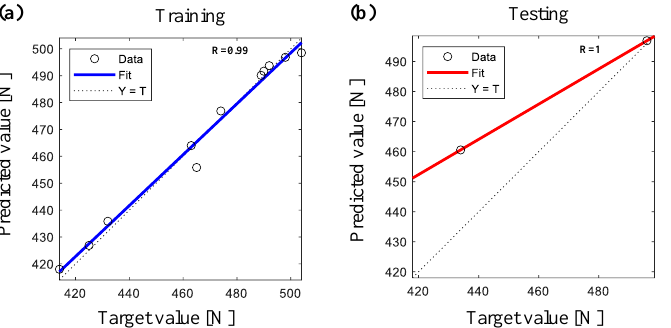
Figure 9. Correlation coefficient between actual and predicted values of tensile strength of cotton after UV treatment using ANN during ( a ) training and ( b ) testing processes.